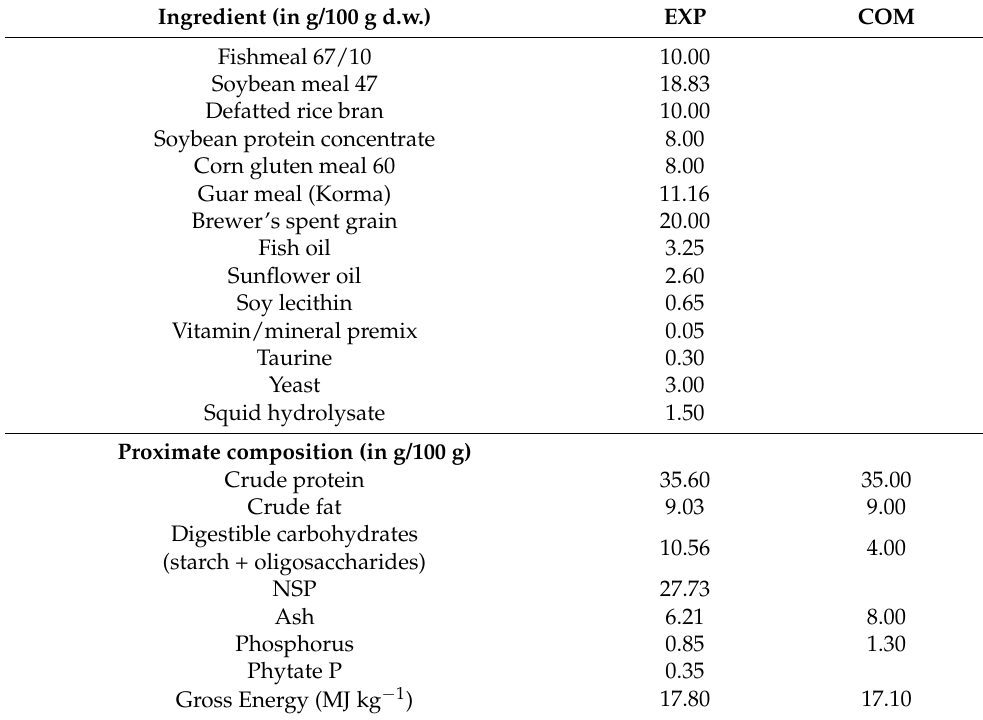
Table 1. Ingredients and proximate composition of the experimental feed used in the experiments. Ingredient (in g/100 g d.w.) EXP COM Fishmeal 67/10